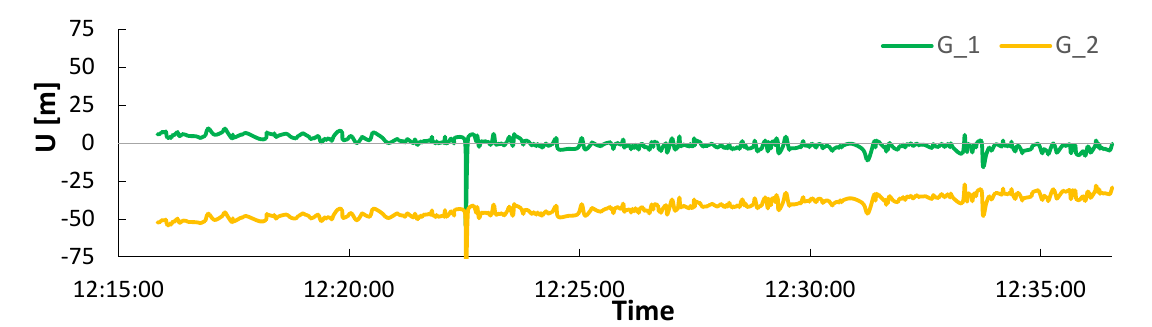
Figure 9. Plot of NE component deviations of linear measurement with code receivers.